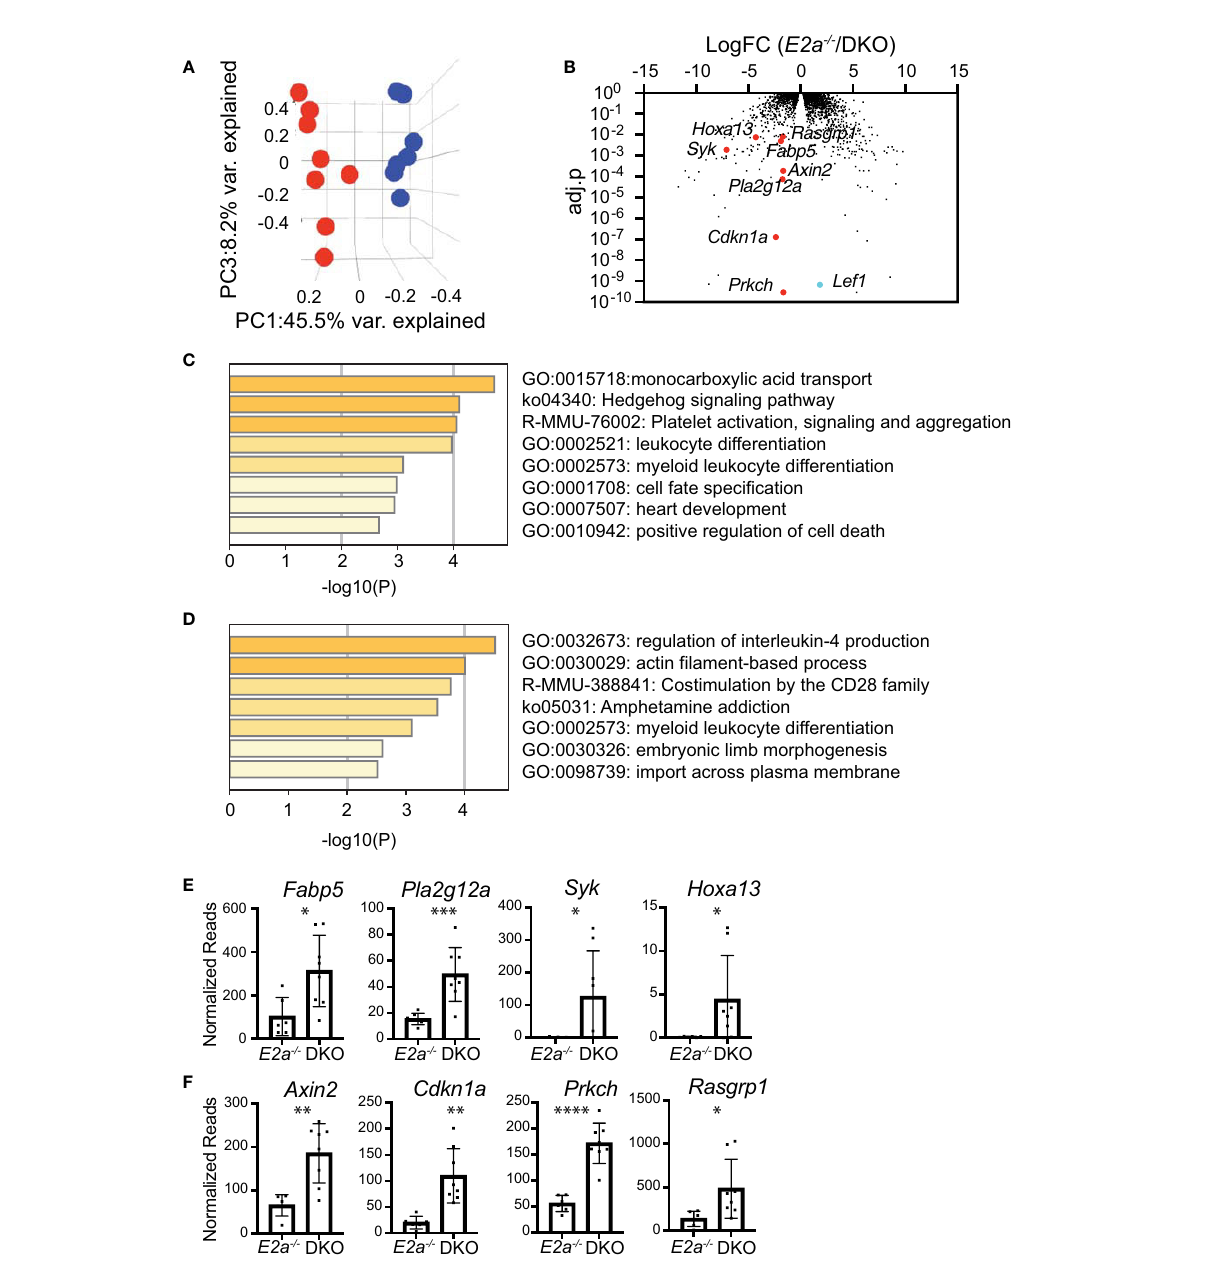
FIGURE 7 | RNA-sequencing of E2a -/- and DKO leukemia lines reveals differences in multiple genes associated with signaling and monocarboxylic acid transport. (A) Principal Component Analysis of E2a -/- (blue) and DKO (red) leukemias based on differential gene expression in RNA-seq analysis. adj.p based on FDR. (B) Volcano plot showing Log2FC by adj.p-value comparing RNA-seq from E2a -/- and DKO leukemias. Lef1 and genes on interest that were higher in DKO as compared to E2a -/- leukemias are indicated. (C) Pathway analysis for genes that are increased in DKO compared to E2a -/- leukemias. (D) Pathway analysis of genes that are decreased in DKO compared to E2a -/- leukemias. (E) Normalized reads for individual E2a -/- and DKO leukemia samples for selected genes in the monocarboxylic acid transport pathway or (F) the Hedgehog Signaling Pathway. *p < 0.05, **p < 0.01, ***p < 0.005, and ****p < 0.0001 by student t-test of individual normalized